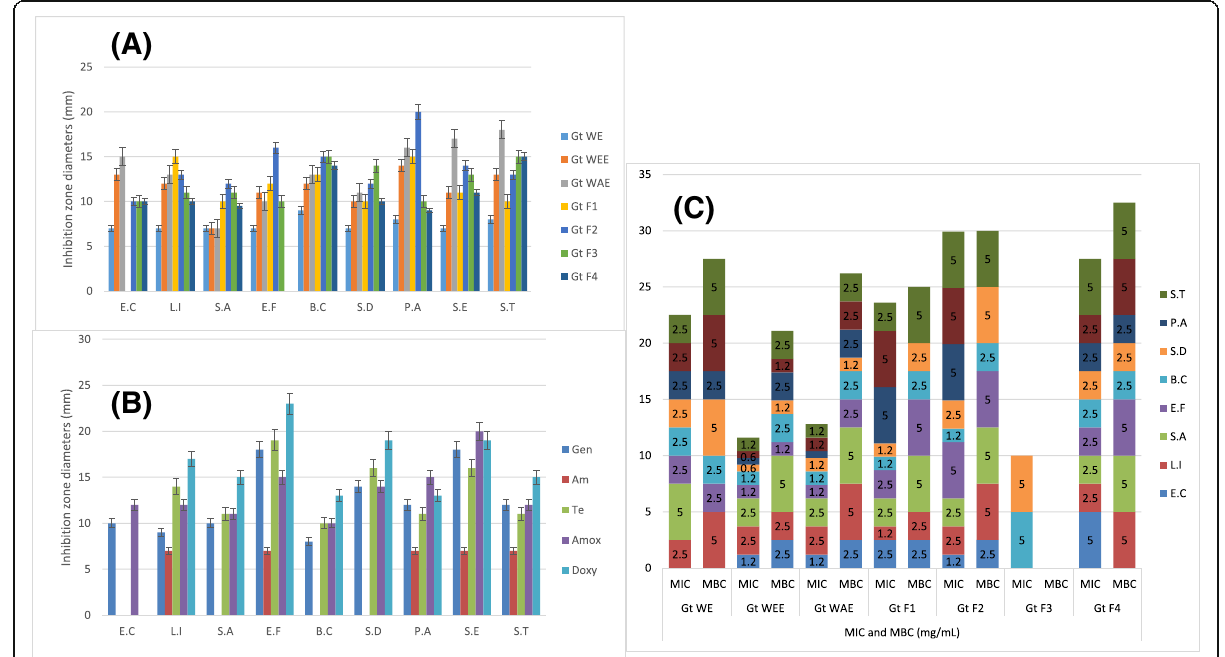
Fig. 1 Antimicrobial activity of total extracts and fractions from Guibourtia tessmanii. a Inhibition zone diameters of extracts, b Inhibition zone diameters of standards, c Minimum inhibitory concentration (MIC) and minimum bactericidal concentration (MBC) of plants extract. WAE = Water- acetone extract; WEE = Water-ethanol extract; F = Fraction; WE = Water extract; Gt = Guibourtia tessmanii J.Léonard;. Gen = Gentamicin; Te = Tetracycline; Am = Ampicillin; Amox = Amoxicillin; Doxy = Doxycycline; E.C = Escherichia coli 105,182 CIP; L. I = Listeria innocua LMG 135668 BHI; S. A = Staphylococcus aureus ATCC 25293 BHI; E. F = Enterococcus faecalis 103,907 CIP; B. C = Bacillus cereus LMG 13569 BHI; S. D = Shigella dysenteria 5451 CIP; P. A = Pseudomonas aeruginosa ; S. E = Salmonella enterica ; S. T = Salmonella typhi